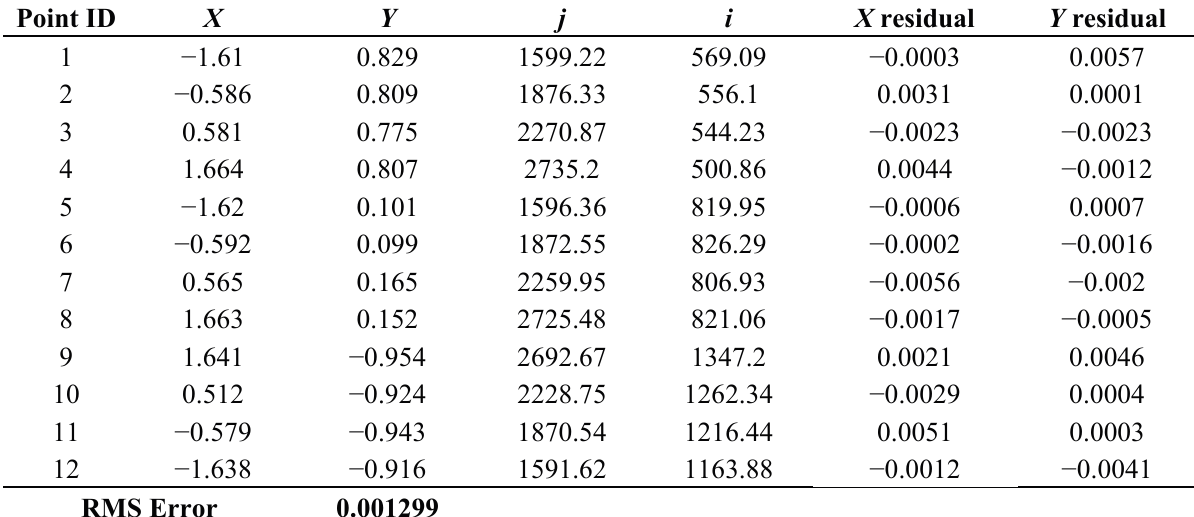
Table 9. Ground, image coordinates and their ground residuals of the original NIKON D100 image.